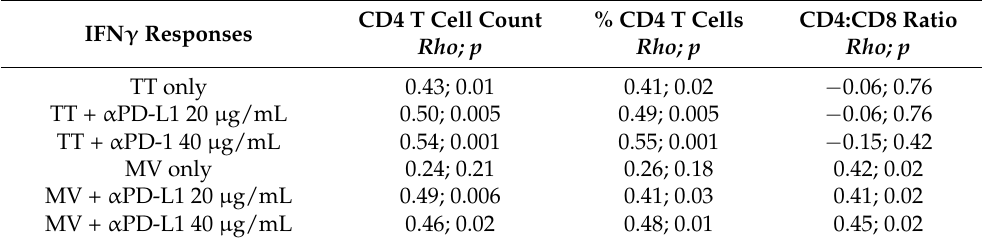
Table 2. Correlation analysis between blood T cell levels and recall IFN γ responses.